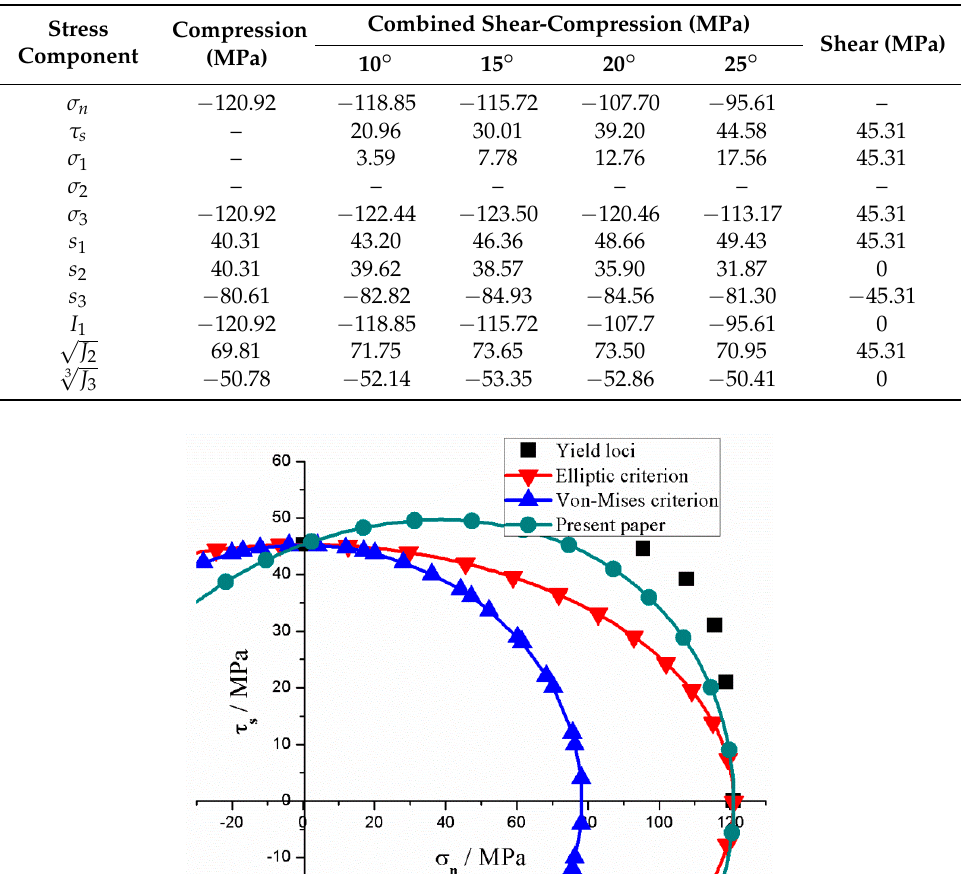
Figure 3. Yield surface in 3–dimension principal stress space ( a ) and π plane ( b ). 4.2. Nanoindentation Measurements of PMMA Figure 4 shows the nanoindentation force–depth curves and the relation of hardness and indentation depth under different P P  . The force–depth curve is typical and contains the loading,